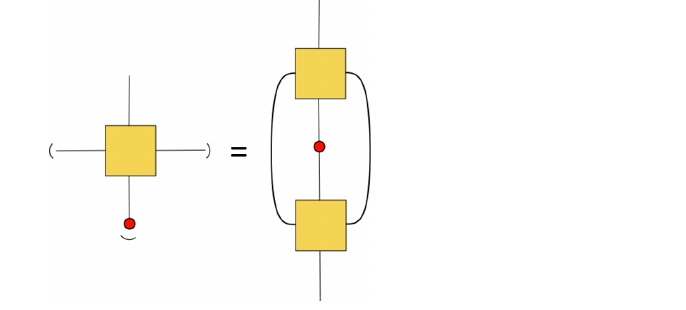
Figure 48. Arc at the end of a tensor leg denotes contracting with its conjugate transpose.